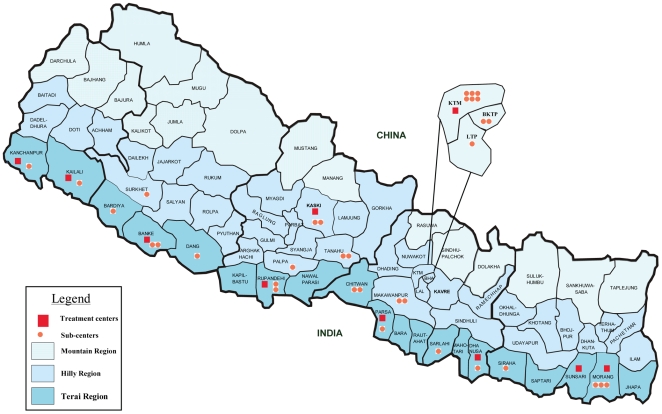
MDR-TB treatment centers and sub-centers in Nepal.Footnote Figure 1: In 2005–2006, not all the health centres were functioning. The 175 cases included in this study were under care at 17 clinics (Bhaktapur, Bheri, Bir, Genetup, Haraicha, HelpHand, INF_Banke, KohalpurMC, Mahakali, Mangalbare, NATA, NMC, NTC, Patan, RTC, Stupa, and TUTH).